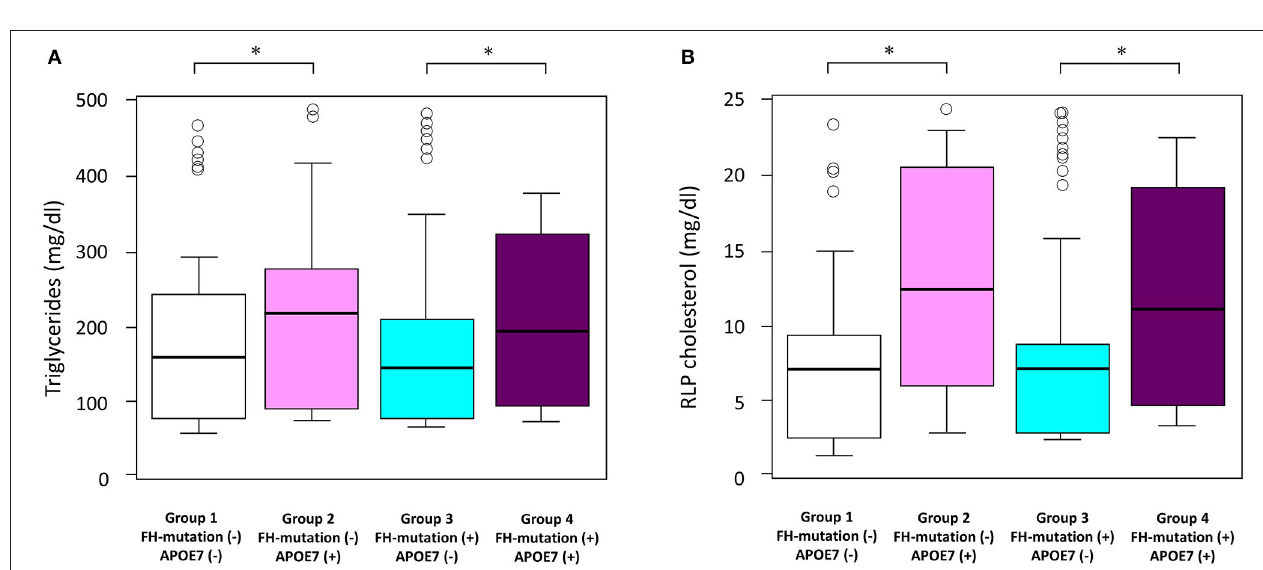
FIGURE 2 | Impact of FH gene and APOE7 on LDL cholesterol. Boxplots are showing LDL cholesterol. * p < 0.05 and ** p < 0.001. Analyses of variance followed by Tukey post-hoc test were used to test the differences among the groups.